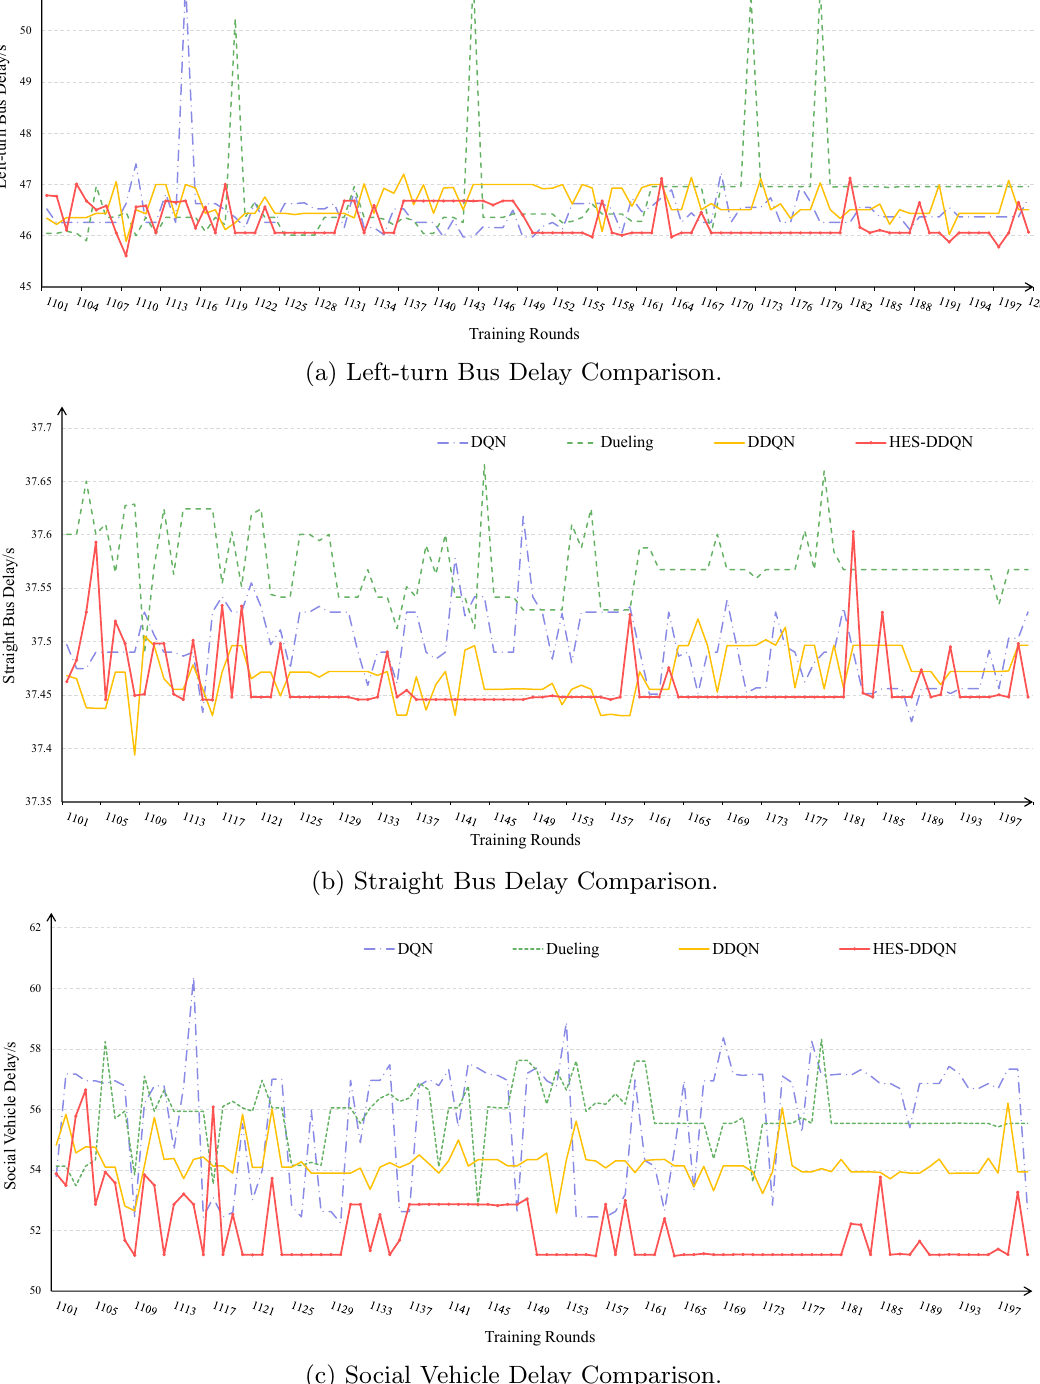
(b) Straight Bus Delay Comparison.